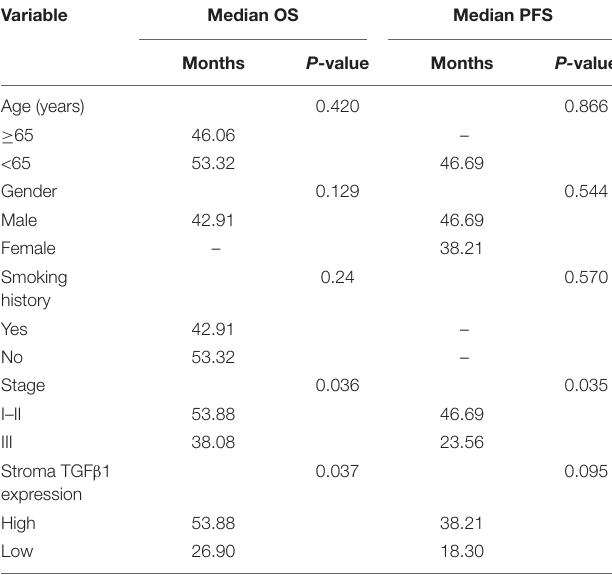
TABLE 2 | Univariate and multivariate ananlysis about impact of clinical features on OS and PFS of 90 patients with SCLC. Variable Median